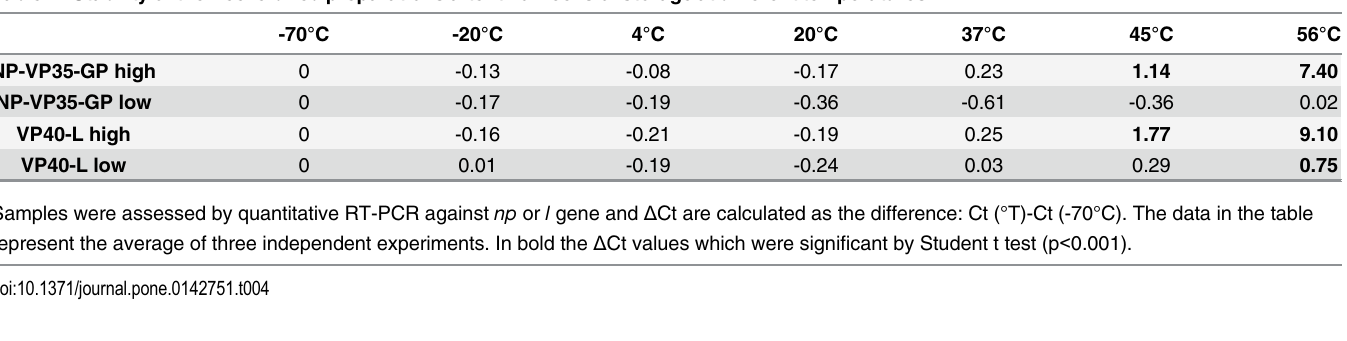
Table 4. Stability of the freeze-dried preparations after two weeks of storage at different